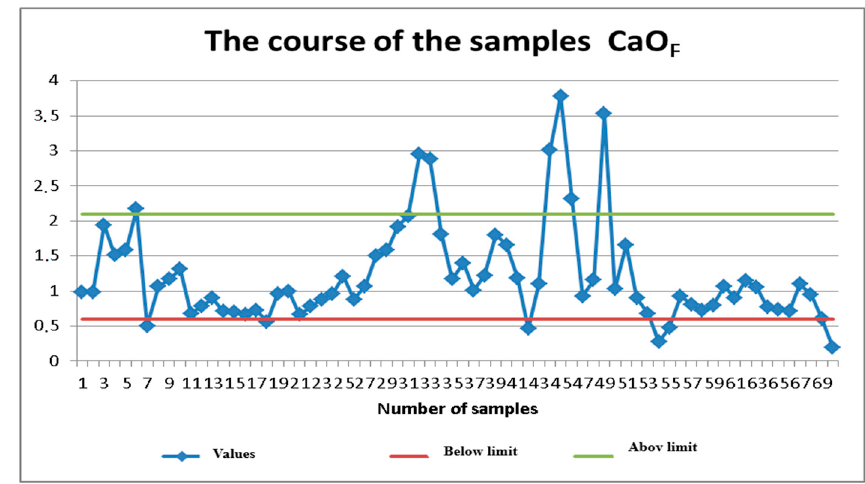
Figure 8. CaO F content in clinker with the limits. Source: own source.